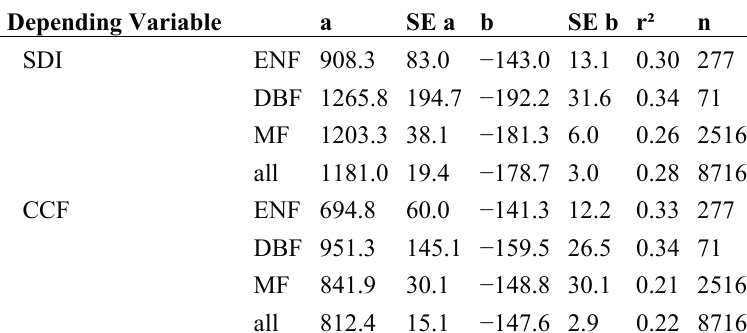
Figure 5. Scatterplots of NPP difference ( ∆ NPP) and stand density dependent trend curves using SDI ( top left ) and CCF ( bottom left ), the trend curves are calculated for MODIS forest land cover types separately (ENF = evergreen needleleaf forest, DBF = deciduous broadleaf forest, MF = mixed forest) and for all land cover types together (all). The images on the right side (Corr. ∆ NPP) show the NPP difference after correcting for stand density given by the trend lines using all plots (all). Table 2. Coefficients and statistics of trend curves displayed in Figure 5 a,b coefficients for Equations (15) and (16), SE standard error of coefficients, r 2 coefficient of determination, n degrees of